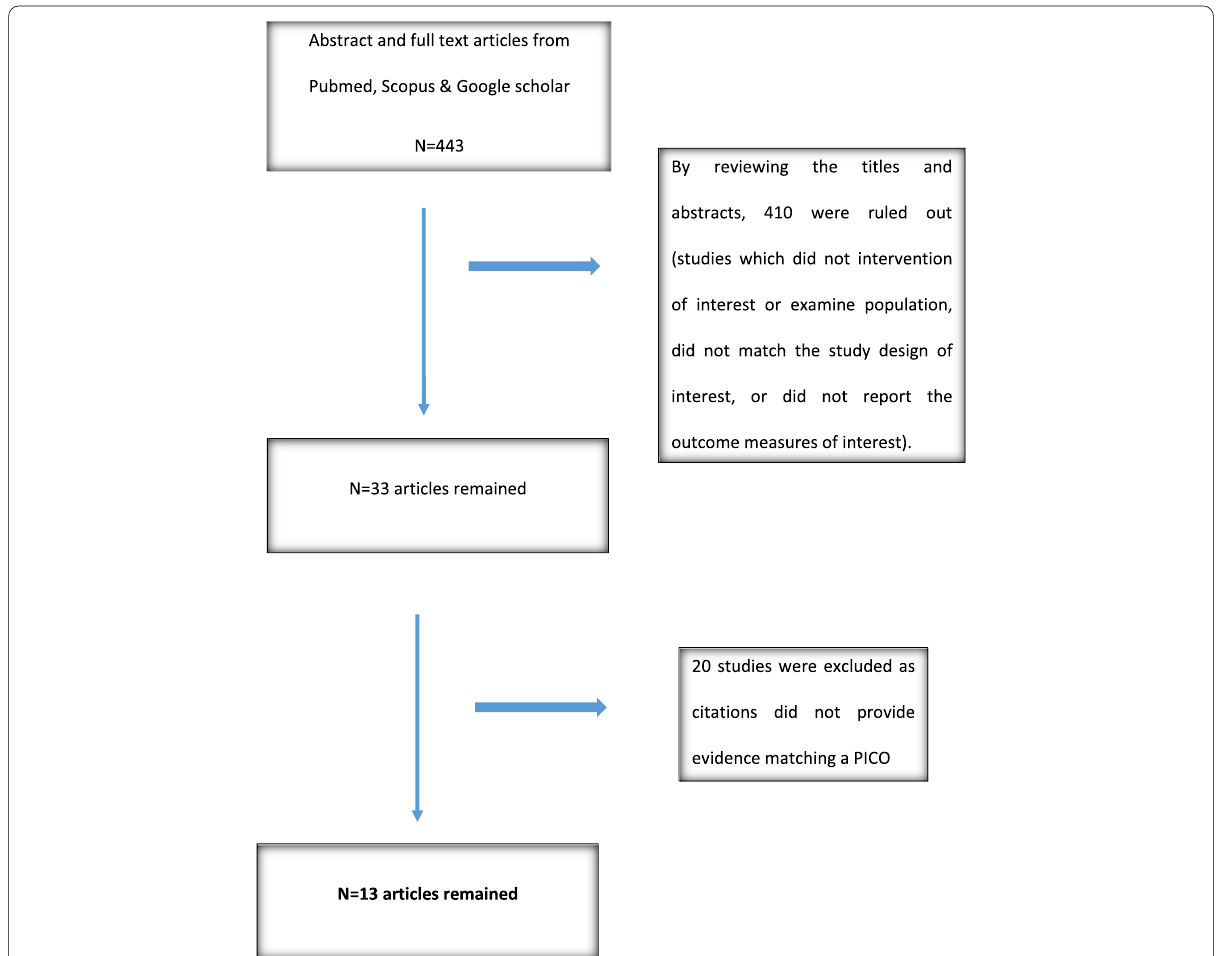
Fig. 1 Flow chart for the study selection